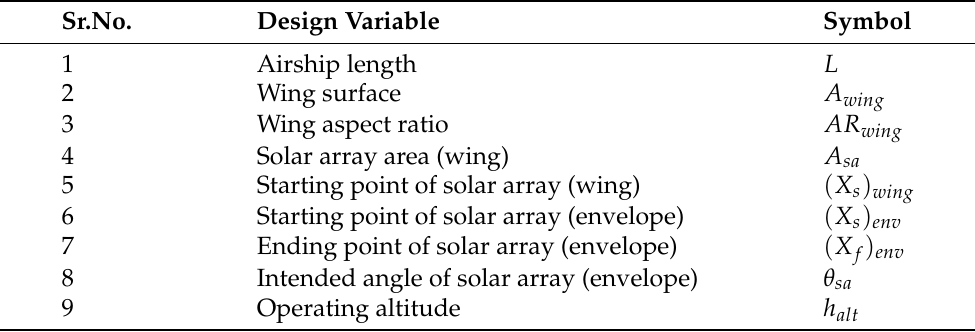
Table 3. Condensed list of design variables—winged configuration. Sr.No.